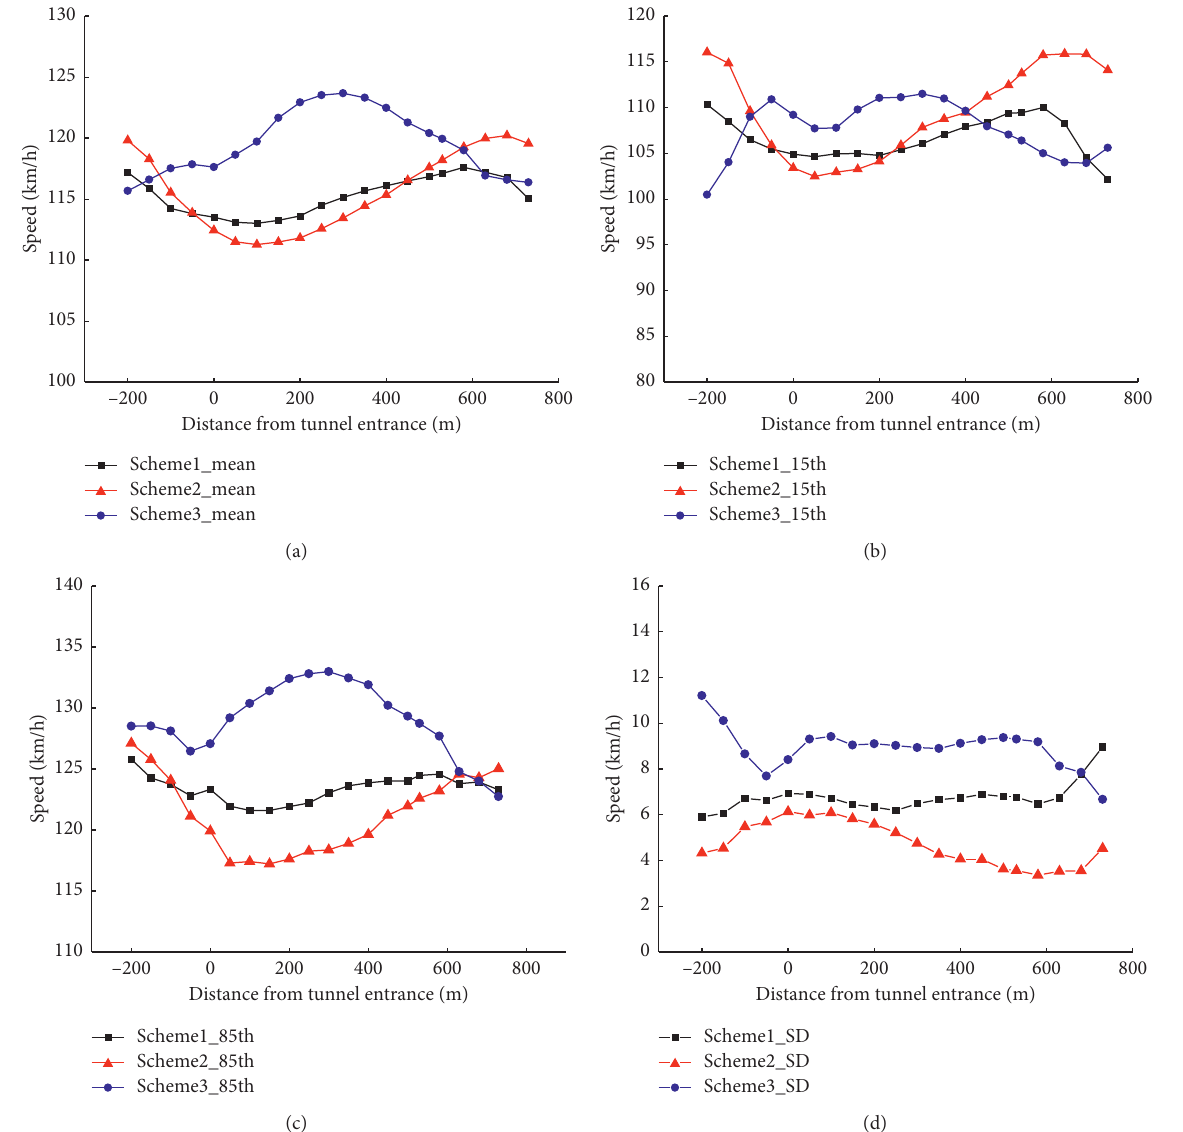
Figure 6: Variation of speed indicators for different right side lateral